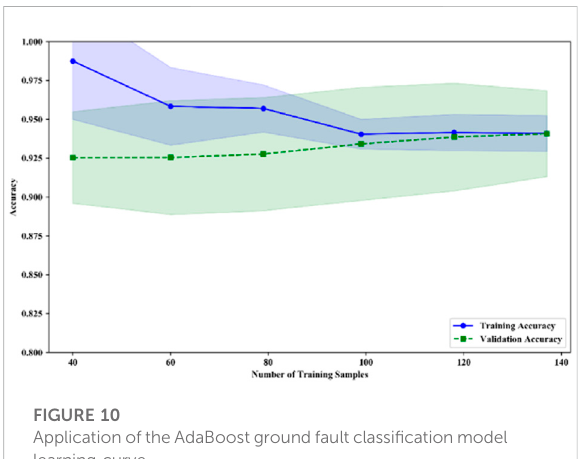
FIGURE 10 ApplicationoftheAdaBoostgroundfaultclassi fi cationmodel learning